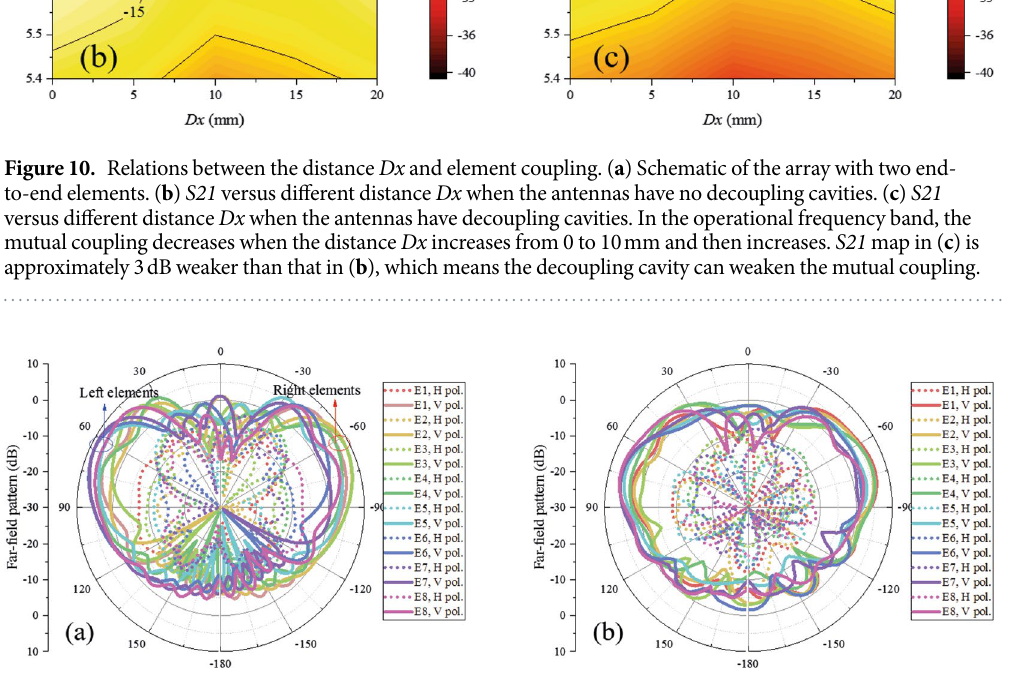
communication system, after a user transmits a detection signal in the tunnel, the proposed array can automatically focus its main beam to the user using a tracking mechanism. In this situation, one main radiation beam can increase the transmission efficiency and avoid signal mutual interference. In other situations, for example, when users are located in two opposite directions and transmit detection signals simultaneously, the proposed array is expected to have multi-beam performance. To demonstrate the multi-beam performance, the proposed array is simultaneously